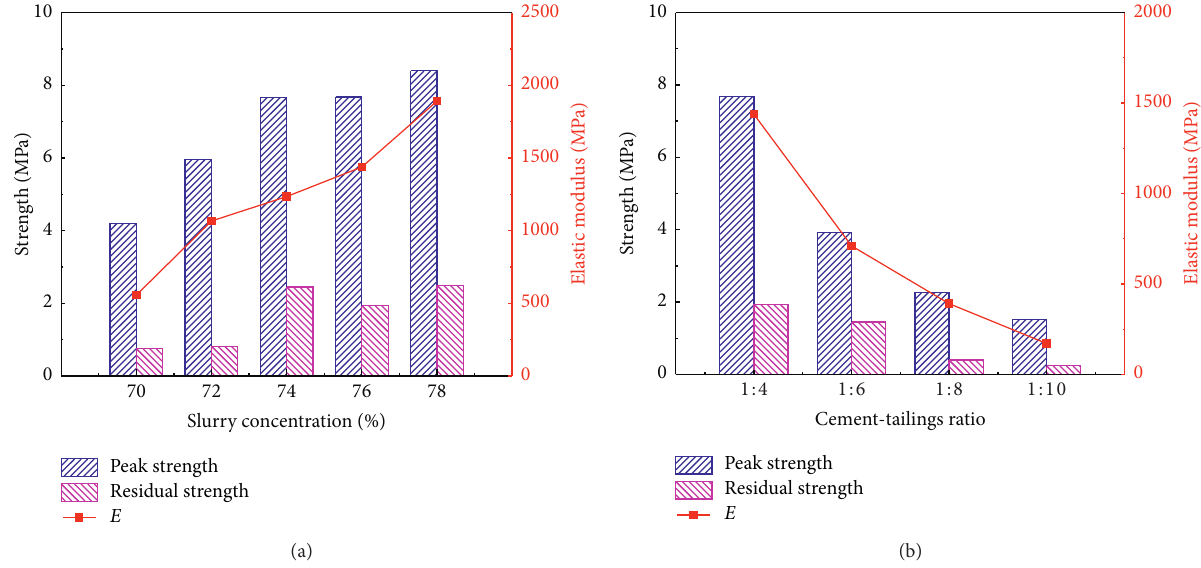
Figure 5: Basic mechanical parameters of CPB. (a) Slurry concentration effect; (b) cement-tailings ratio